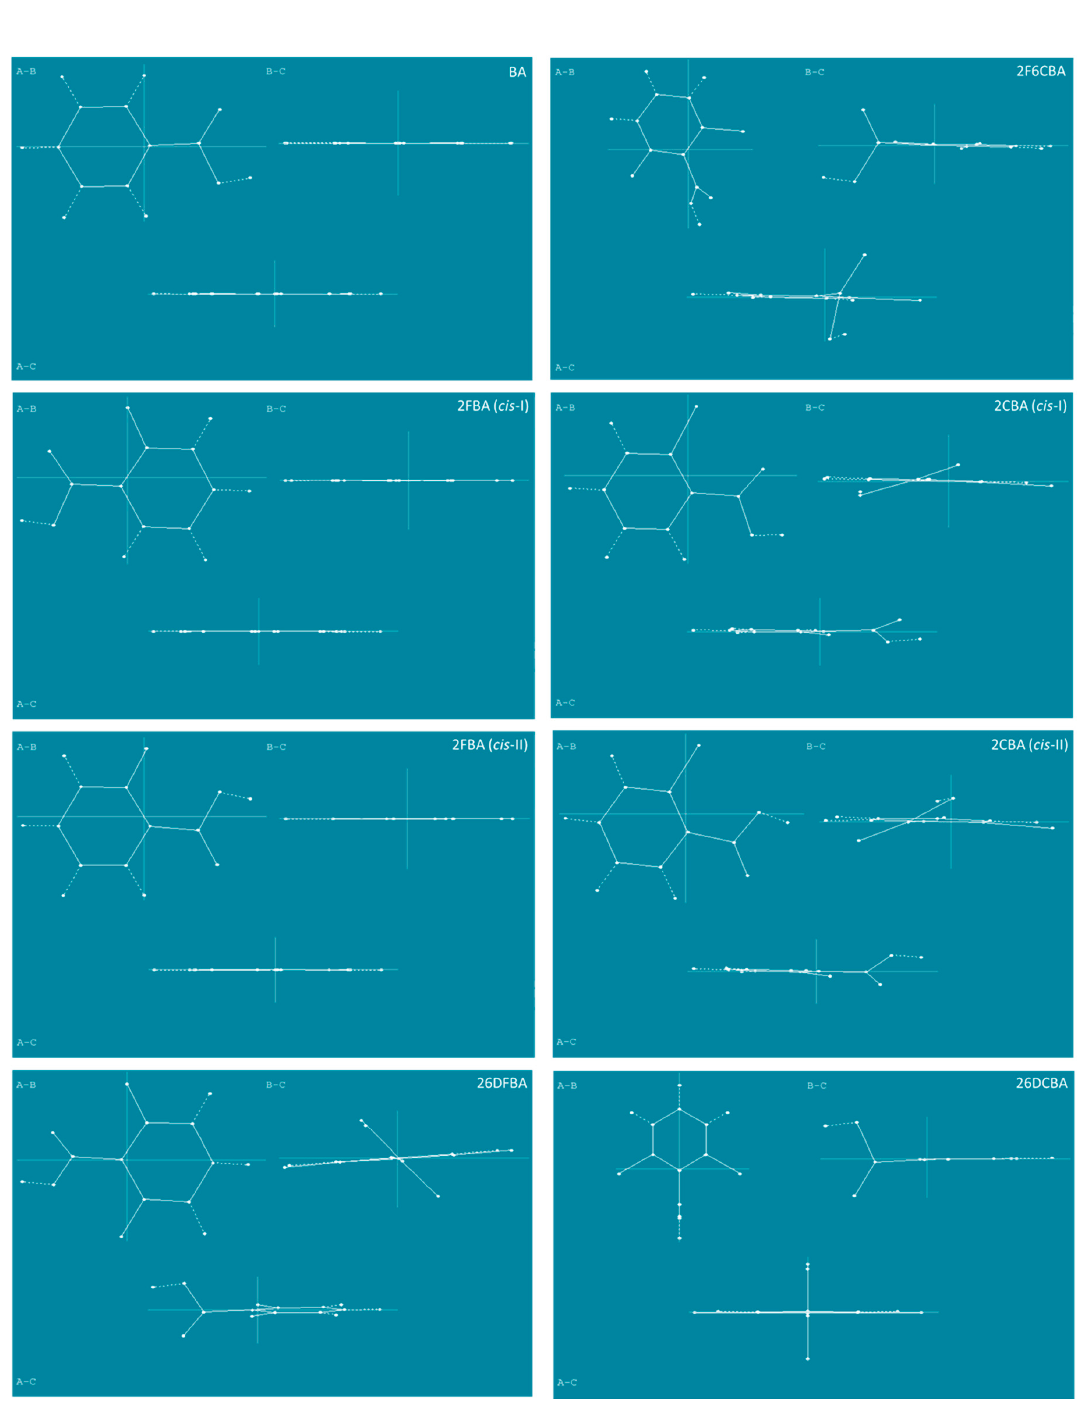
Figure 12. Projection of the experimentally relevant cis conformers of the studied molecules in the planes defined by the principal inertial axes, which are also represented in the figure, with lengths proportional to their associated rotational constants, A, B, C.